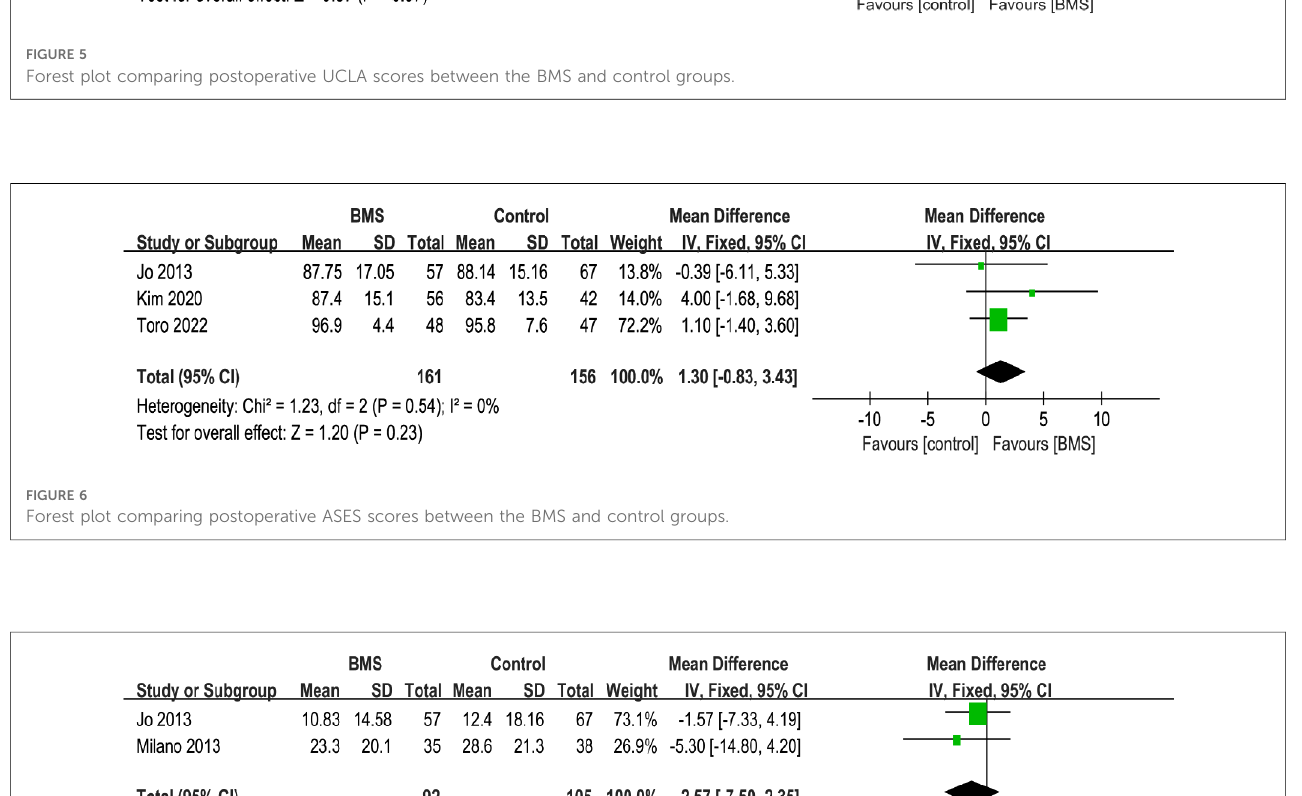
patients with rotator cuff tears, Sakamoto et al. found that the average minimum distance between the trabecular separation was 0.7 mm (63). Therefore, based on similar studies on the knee, we